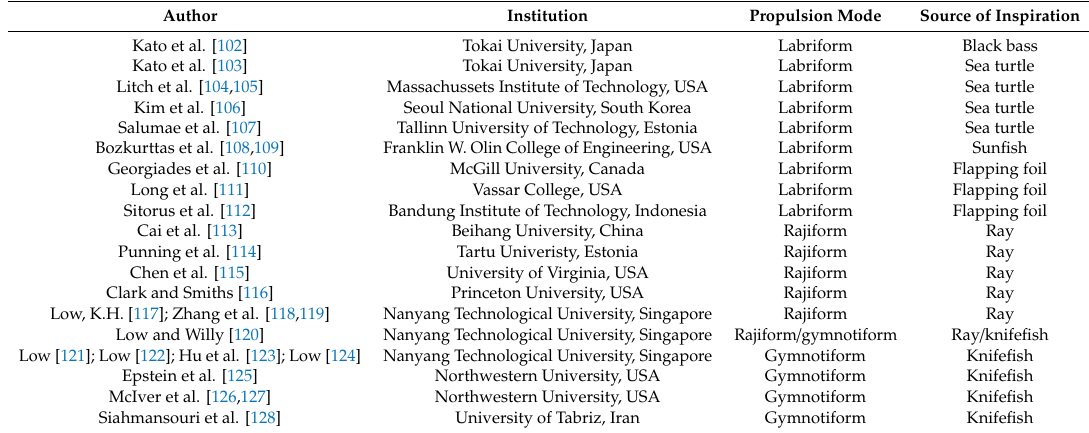
Table 2. Summary of median and paired fin (MPF) swimming